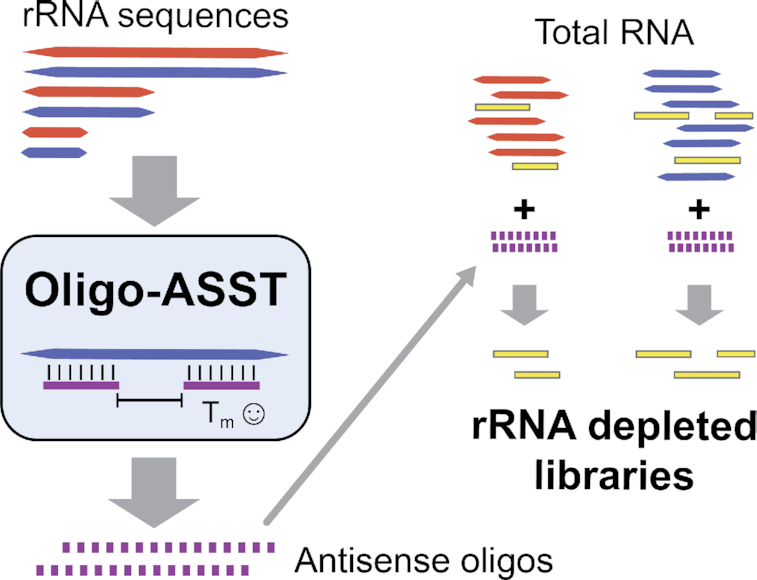
Oligo-ASST designs optimized antisense oligo sets to target RNAs for depletion.